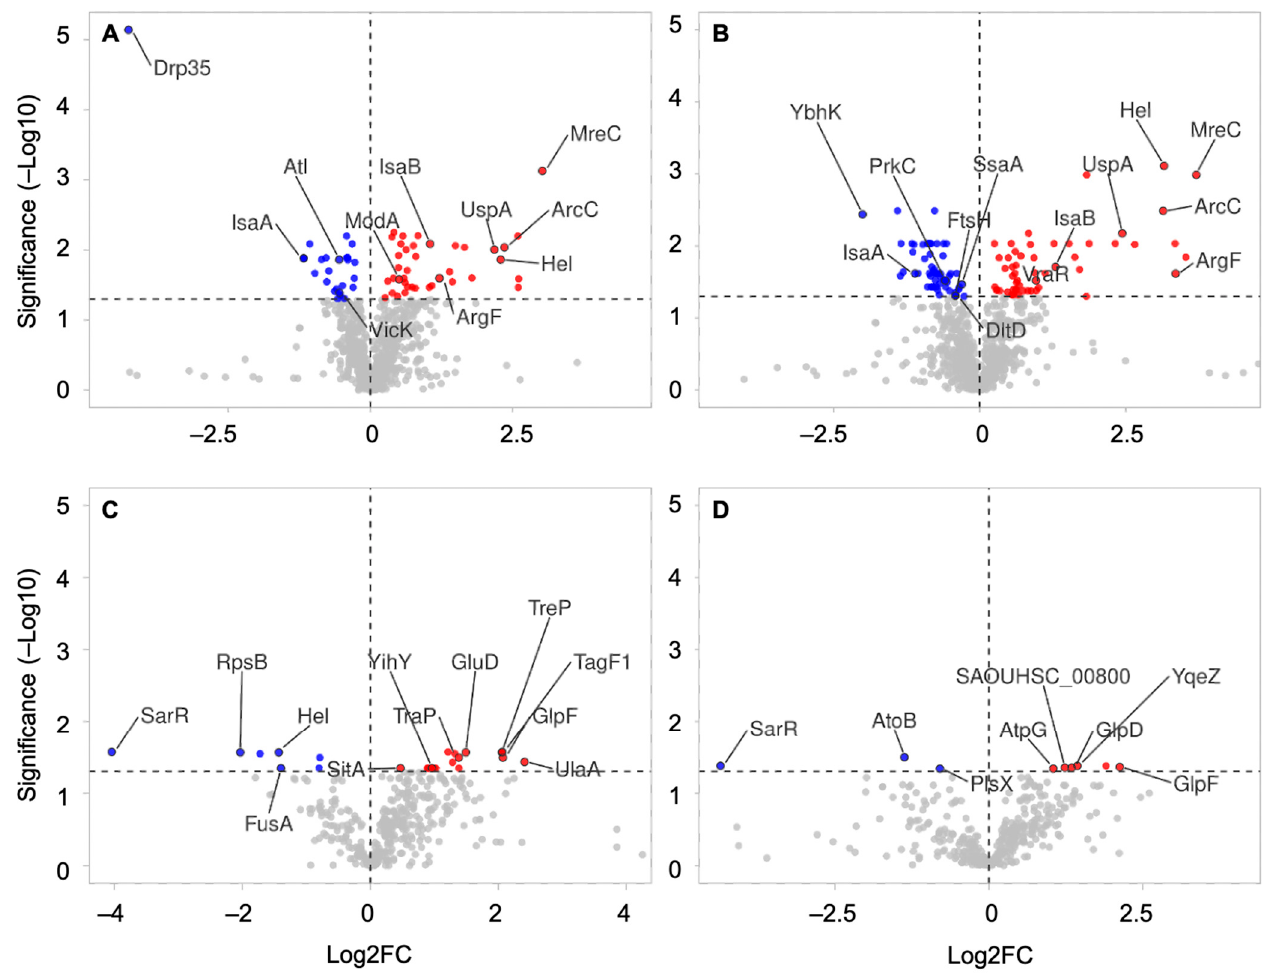
Figure 5. Volcano plot showing differently abundant proteins between growth phases. The graphs provide the log2 fold change (log2FC) ratios between 12 h and 6 h (12/6) conditions from WC without vancomycin ( A ), WC with vancomycin ( B ), EVs without vancomycin ( C ), and EVs with vancomycin ( D ). The vertical and horizontal dotted lines show the FC and threshold of significance (adjusted p -value < 0.05), respectively. The results are plotted in dots on a logarithmic scale, with negative log2FC in blue, positive log2FC in red, and nonsignificant values in